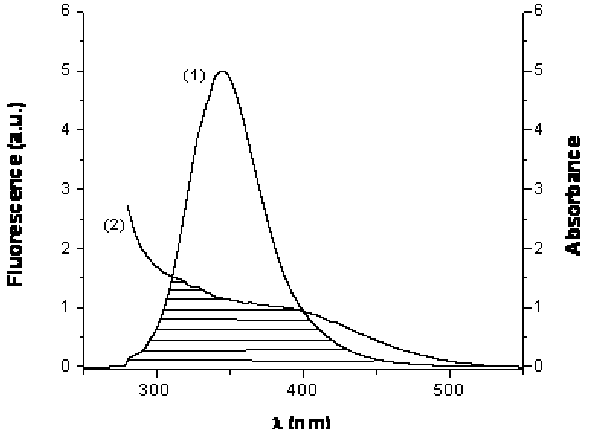
Figure 6 . Overlap of the fluorescence spectrum of BSA (1) and absorption spectrum of HEBID